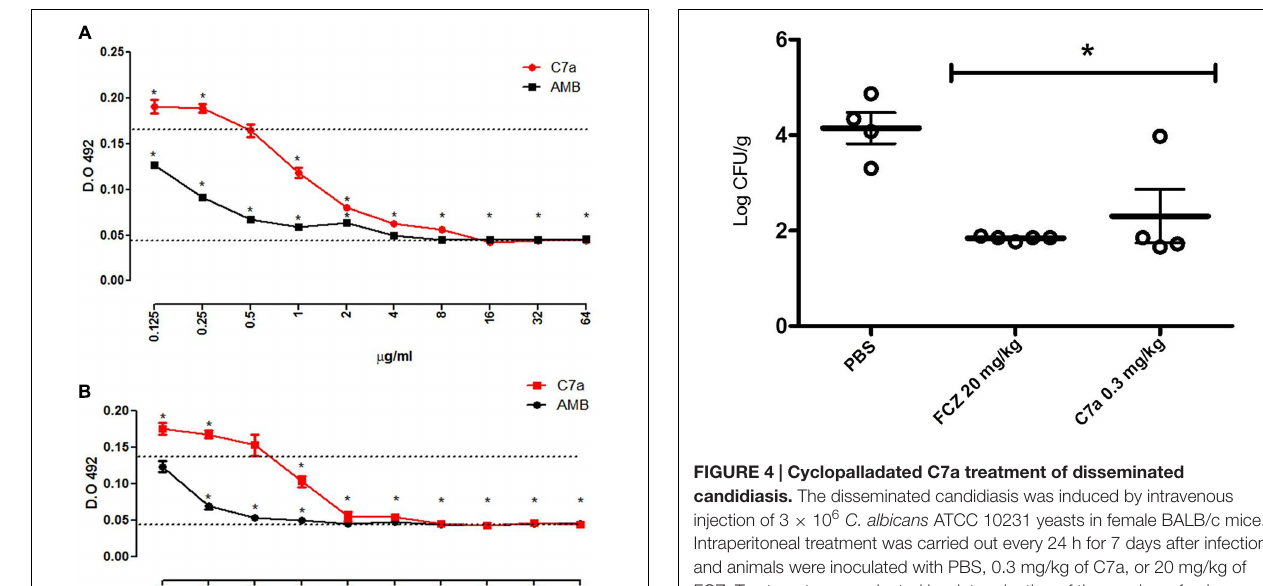
Frontiers in Microbiology |